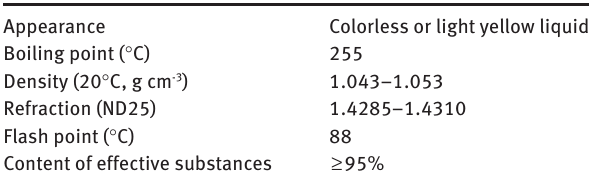
Table 2 Performance parameters of the silane coupling